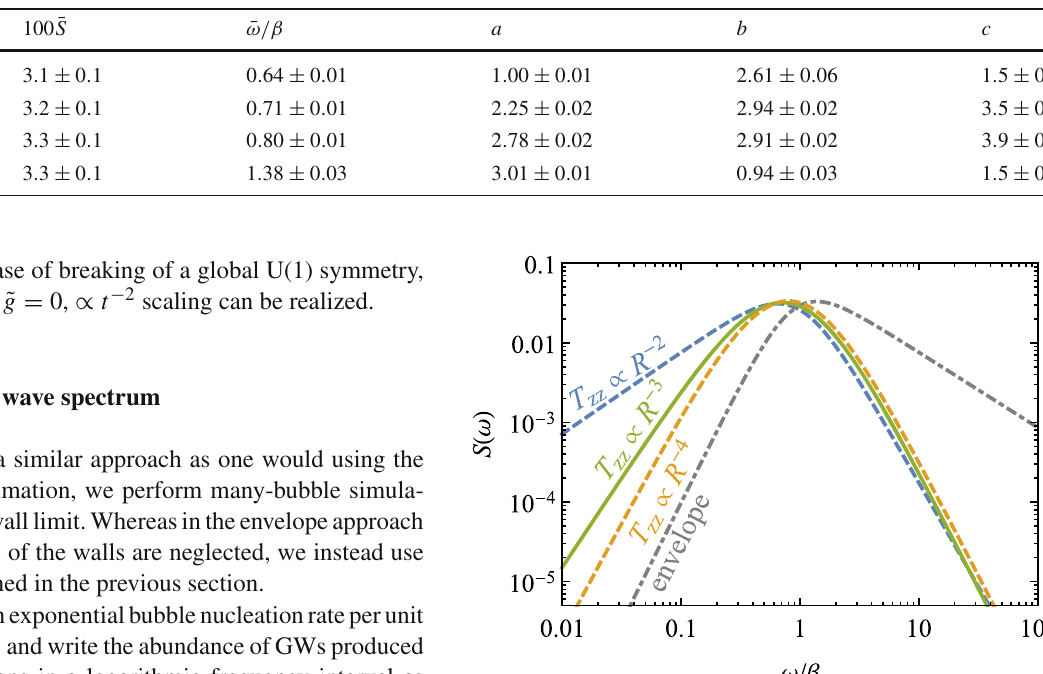
Table 1 Fitted values for the parametrization of the spectral shape (12)